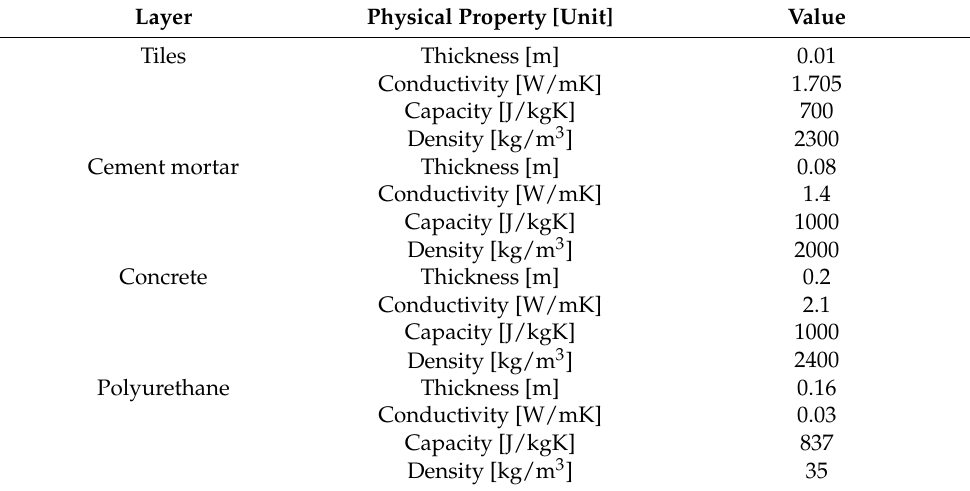
Table 2. Thermal properties of floor structure consisting of 4